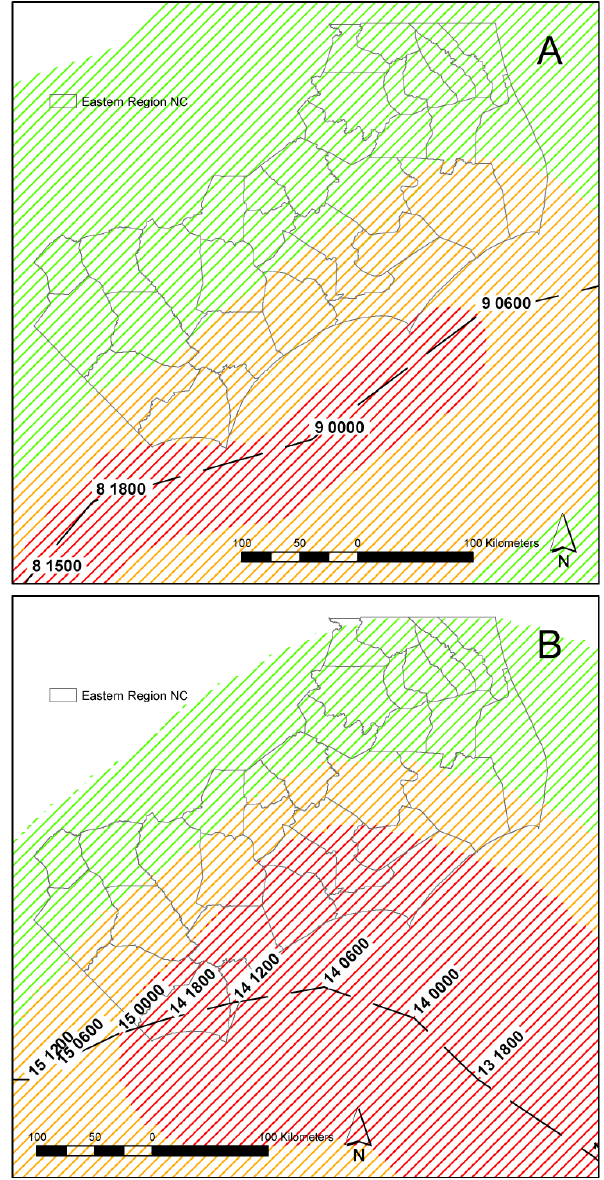
Figure 2. Track and wind speeds during the passage of hurri- canes (a) Matthew and (b) Florence off the coast of North Car- olina. Red stippling indicates hurricane force winds ( > 33ms − 1 ), orange storm force ( > 26ms − 1 ), and green tropical storm force ( > 17ms − 1 ). The track is denoted by the dashed line. The first number is the day, and the second number is the time (UTC) in October 2016 for (a) and September 2018 for (b) .